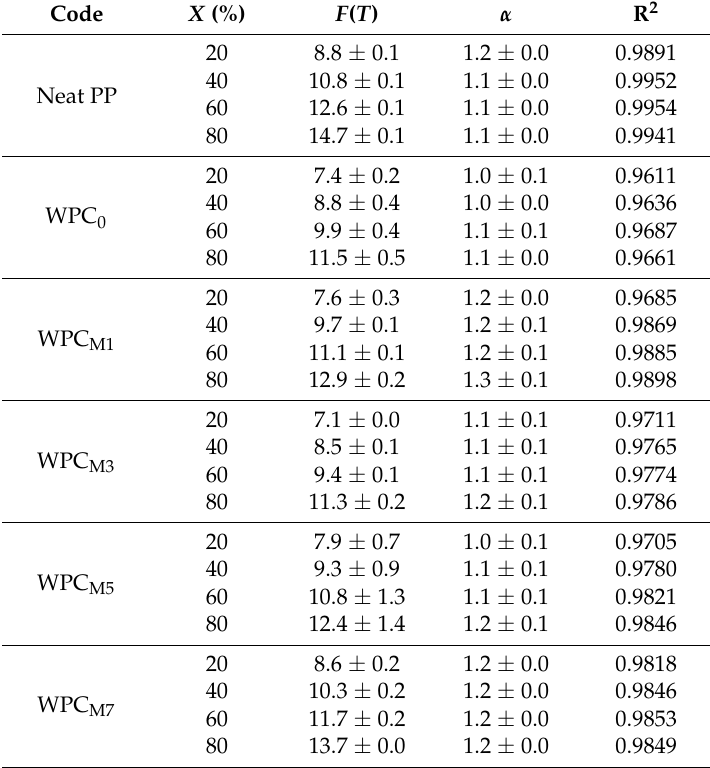
Table 3. The parameters calculated at various relative crystallinities ( X ) based on the Avrami–Ozawa model.